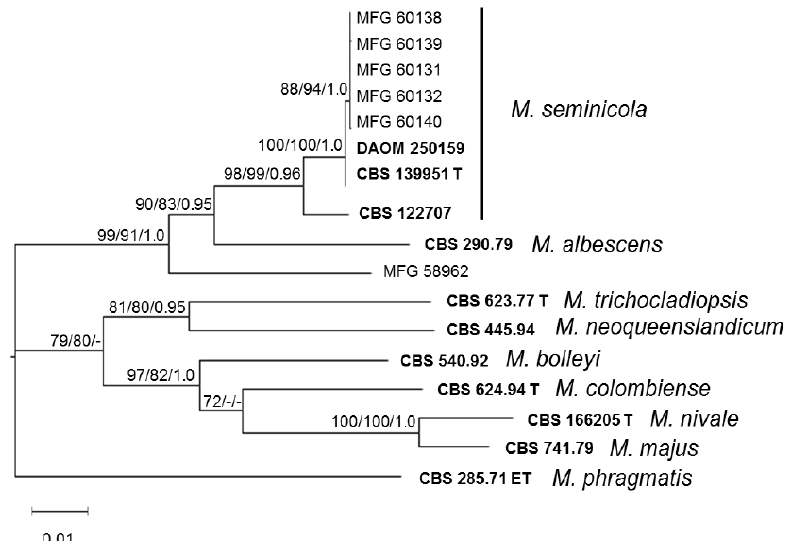
Figure 1. Maximum likelihood (ML) phylogenetic tree based on DNA sequence data from four loci (ITS, LSU, BTUB, and RPB2) of Microdochium species. ML and maximum parsimony (MP) bootstrap support values > 70%, followed by Bayesian posterior probability scores > 0.95 are shown at the nodes . The tree was rooted with Microdochium phragmitis . T, ex-type strain; ET, ex-epitype strain.